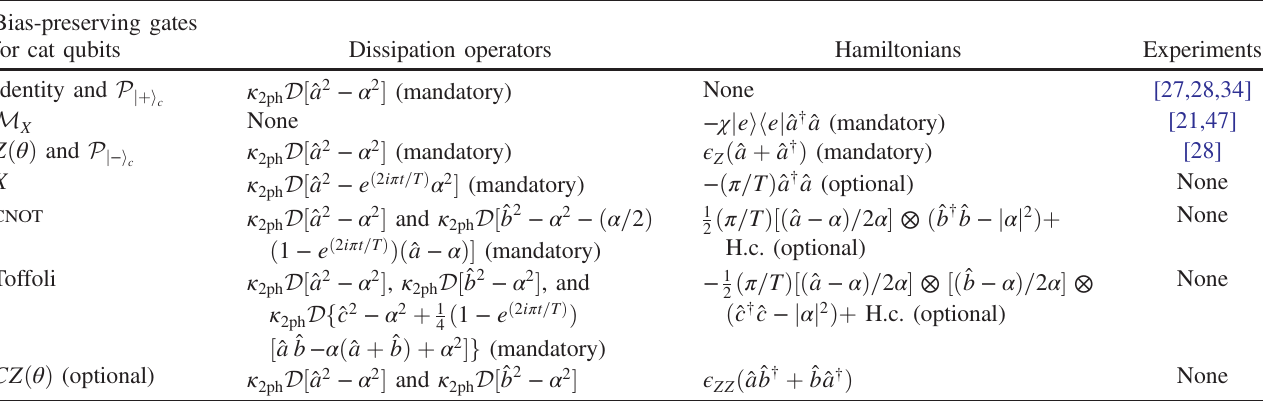
TABLE II. Dissipation operators and Hamiltonians required for universal and fault-tolerant quantum computation with cat qubits. The mandatory Hamiltonians and dissipators are required to achieve bias-preserving operations at the level of cat qubits which, embedded in a repetition code, lead to a universal set of fault-tolerant logical gates. The optional Hamiltonians reduce the phase-flip error rate induced by the nonadiabatic effects of the bias-preserving operations. Such an improvement can lead to a drastic reduction of the number of the required cat qubits in a repetition code, in order to reach a certain desired error level. While some of the operations in the table have already been implemented in experiments with superconducting circuits, all the other ones should be simple modifications or extensions of the current